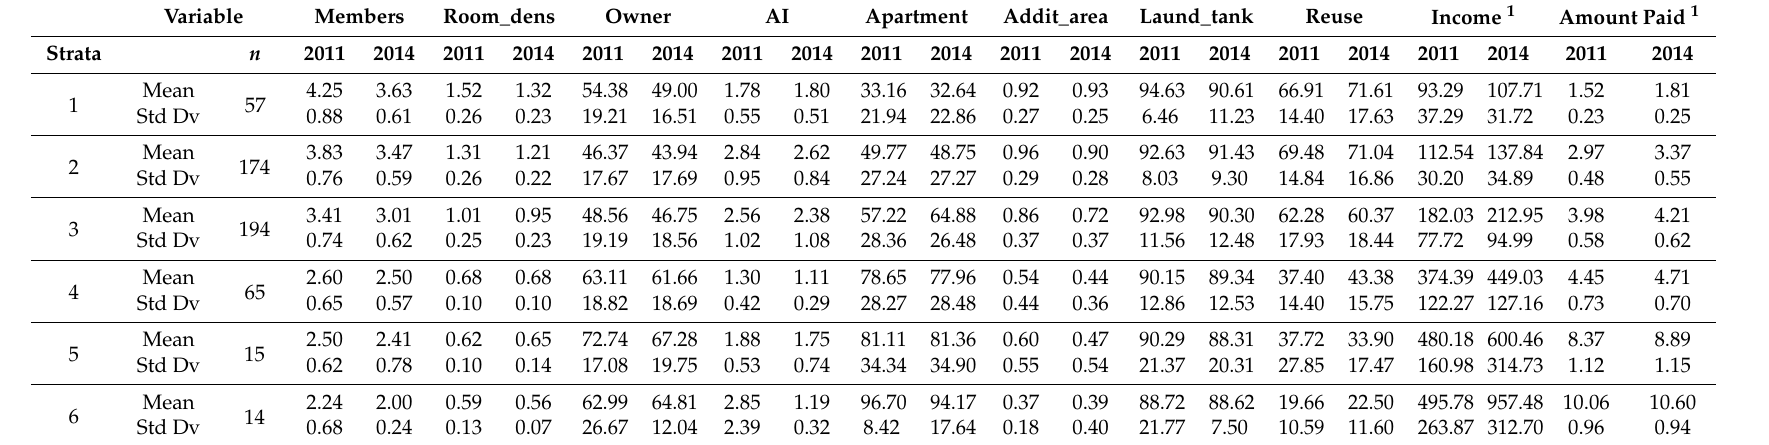
Table A10. Mean and standard deviation of independent